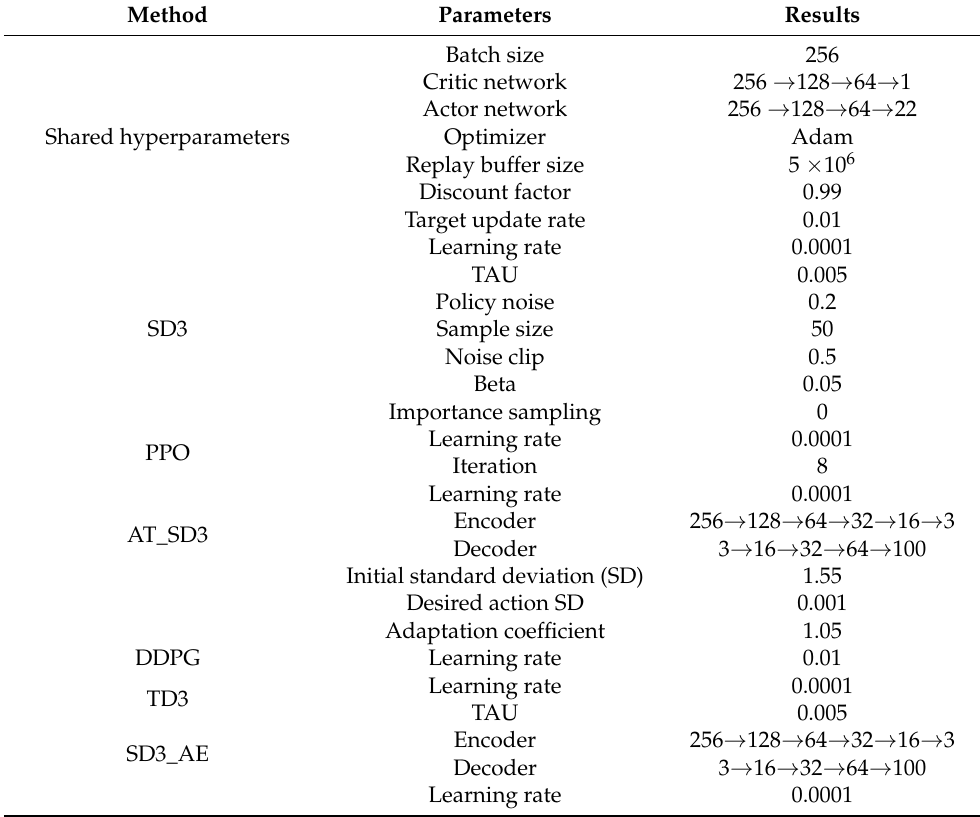
Table 2. Hyperparameters of TD3 [14], DDPG [13], SD3, SD3_AE, PPO [15] and